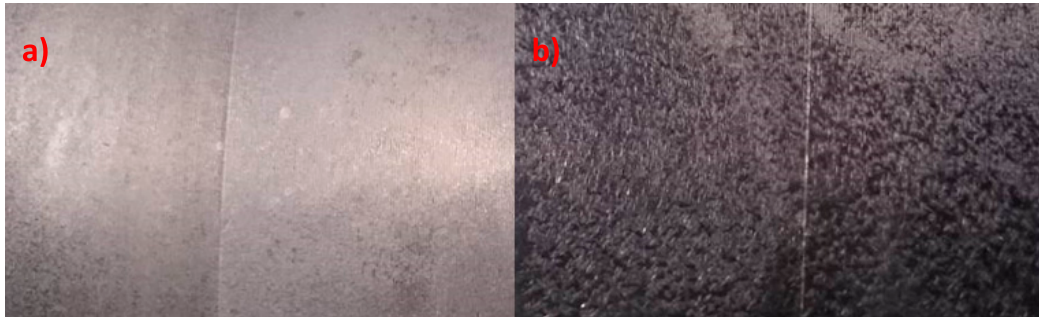
Figure 5. E ff ects of the substrate on the quality of the produced phosphate coating: ( a ) 235JR steel Figure 5. Effects of the substrate on the quality of the produced phosphate coating: a ) 235JR steel without chromium and molybdenum; ( b ) 42CrMoS4 + QT chromium-molybdenum steel. without chromium and molybdenum; b ) 42CrMoS4+QT chromium-molybdenum steel. Table 6. Comparison of the qualitative composition of 42CrMoS4 + QT and S235JR steels [23,24]. Stal 42CrMoS4 + QT